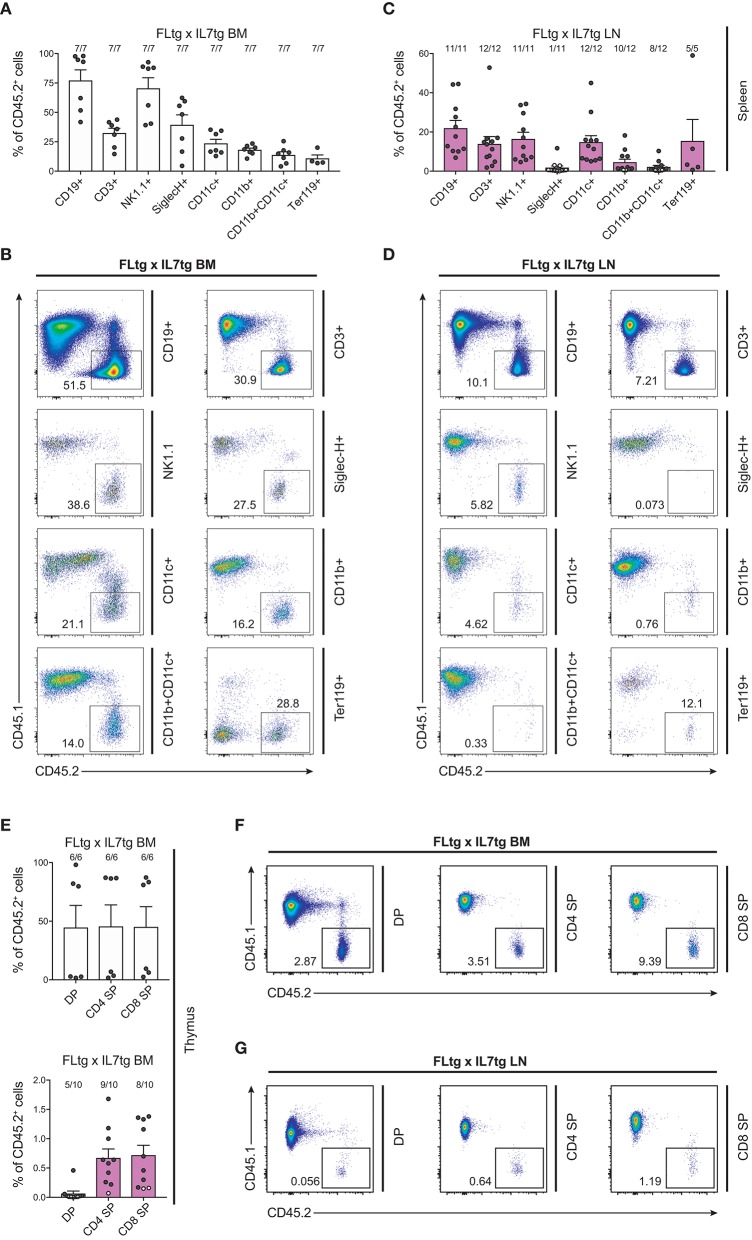
Hematopoietic reconstitution potential of FLtgxIL7tg LN cells. (A,C) Percentage of CD45.2+ donor cells within the indicated lineages in spleens of mice reconstituted with FLtgxIL7tg BM (A) or FLtgxIL7tg LN (C). Results from four independently performed experiments are shown. Bars indicate mean ± standard error of the mean. Black circles represent mice where the corresponding lineage was scored as positive for the presence of donor-derived cells (>50 cells in the CD45.2+ gate) and white circles mice with no reconstitution (<50 cells in the CD45.2+ gate). The fraction of positive-to-total mice analyzed for each lineage is indicated above the corresponding bar. Lineages were defined as follows: CD19+: CD11b−CD11c−CD3−CD19+; CD3+: CD11b−CD11c−CD19−CD3+; NK1.1+: CD3−CD11c−B220−SiglecH−NK1.1+; SiglecH+: CD11b−NK1.1−B220+SiglecH+; CD11c+: NK1.1−SiglecH−B220−CD11b−CD11c+; CD11b+: NK1.1−SiglecH−B220−CD11c−CD11b+; CD11b+CD11c+: NK1.1−SiglecH−B220−CD11b+CD11c+; Ter119+: Ter119+. (B,D) Representative FACS plots showing the CD45.2+ donor population identified within the lineages shown in (A,C). Left: recipients transplanted with FLtgxIL7tg BM; Right: recipients transplanted with FLtgxIL7tg LN. (E) Percentage of CD45.2+ donor cells within the indicated T cell populations in thymi of mice reconstituted with FLtgxIL7tg BM (upper) and FLtgxIL7tg LN (lower). Results from three independently performed experiments are shown. For FLtgxIL7tg BM: n = 6; for FLtgxIL7tg LN: n = 10. Bars indicate mean ± standard error of the mean. Black circles represent mice where the corresponding lineage was scored as positive for the presence of donor-derived cells (>50 cells in the CD45.2+ gate) and white circles mice with no reconstitution (<50 cells in the CD45.2+ gate). The ratio of positive-to-total mice analyzed for each lineage is indicated above the corresponding bar. Cells were identified as follows: DP: CD3+CD4+CD8+; CD4 SP: CD3+CD8−CD4+; CD8 SP: CD3+CD4−CD8+. (F,G) Representative FACS plots showing the CD45.2+ donor population identified within the indicated thymic T cell populations. Upper: recipients transplanted with FLtgxIL7tg BM; lower: recipients transplanted with FLtgxIL7tg LN.